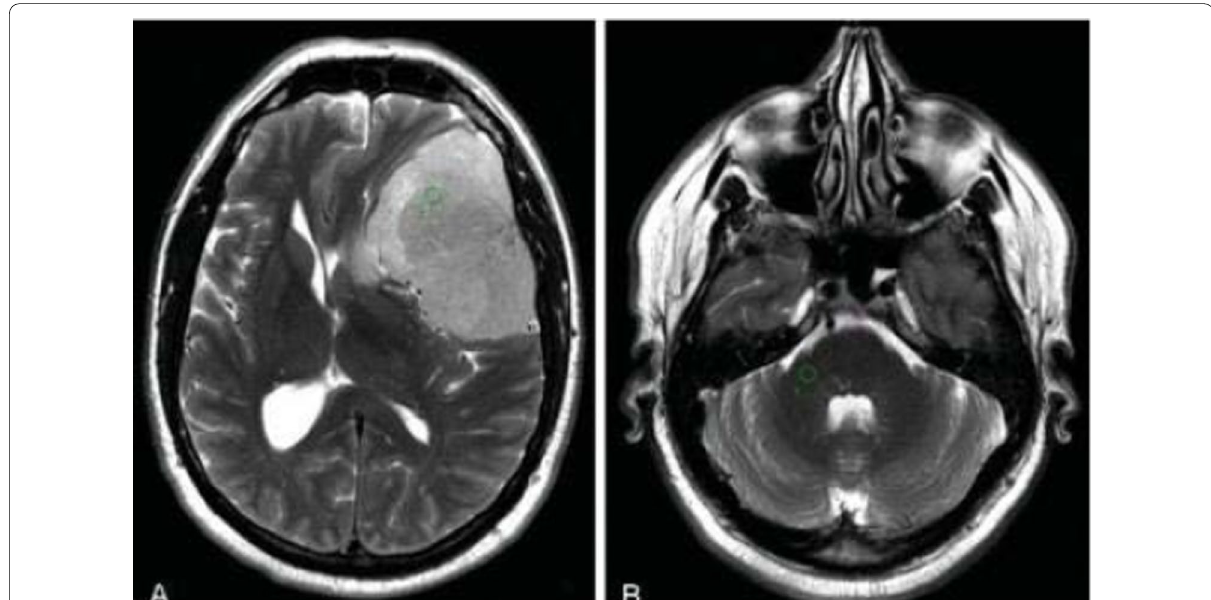
Fig. 1 How to use the tumor to cerebellar peduncle T2-weighted imaging intensity (TCTI) ratio. A Region of interest (ROI) in tumor on T2 sequence. B ROI in middle cerebellar peduncle on T2 sequence. Calculating the TCTI ratio. TCTI ratio intensity value for ROI within tumor ( A )/Intensity value for ROI within middle cerebellar peduncle ( B )